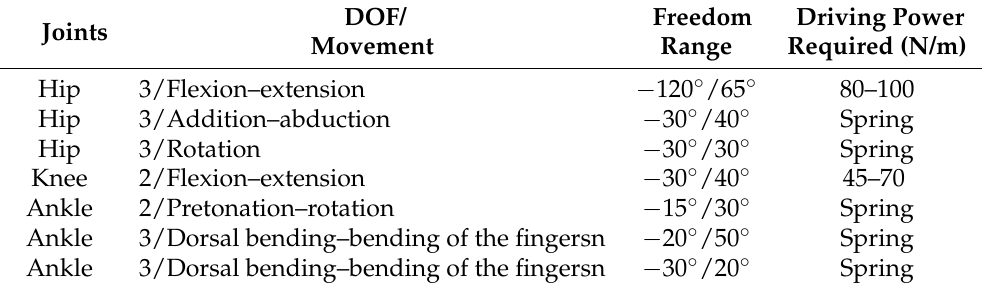
Table 3. DOF design for lower extremity